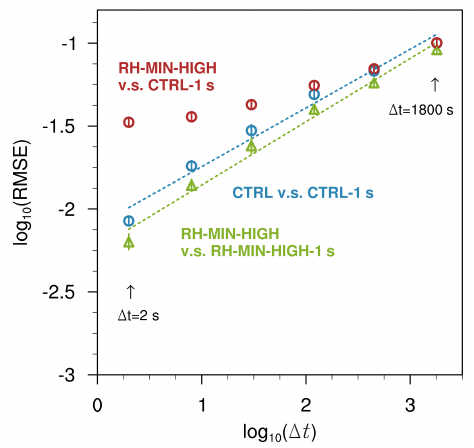
Figure 2. Convergence diagram showing the root mean square (rms) solution differences calculated using the instantaneous 3-D temperature field after 1h of CAM5 integration. Blue circles and green triangles are the rms differences relative to reference solu- tions obtained with the same code but using a 1s time step. Red circles are the rms differences between the reference solution of the CTRL model (1s time step) and the RH-MIN-HIGH simula- tions with longer step sizes. Each marker shows the average rms difference of 12 ensemble simulations that used different initial con- ditions sampled from different months of the year; the bars indi- cate the ± σ ranges where σ denotes the ensemble standard devi- ation. The dashed lines are linear fits between log 10 ( RMSD ) and log 10 ((cid:49)t)